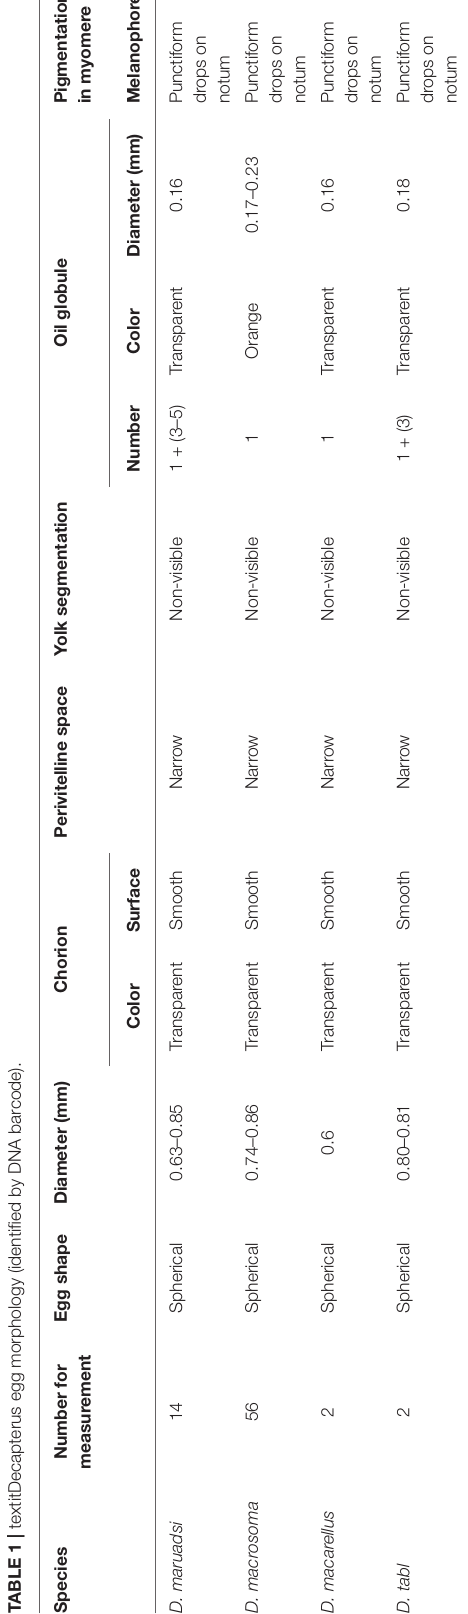
Seasonal Distribution of